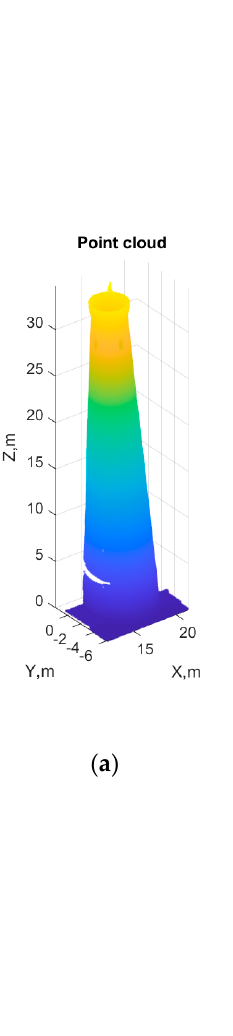
Figure 4. Point cloud of the minaret, adjusted for the global orientation of the walls: ( a ) point cloud with a horizontal section shown in magenta; ( b ) plan view of the horizontal slice at an elevation of 3.5 m.